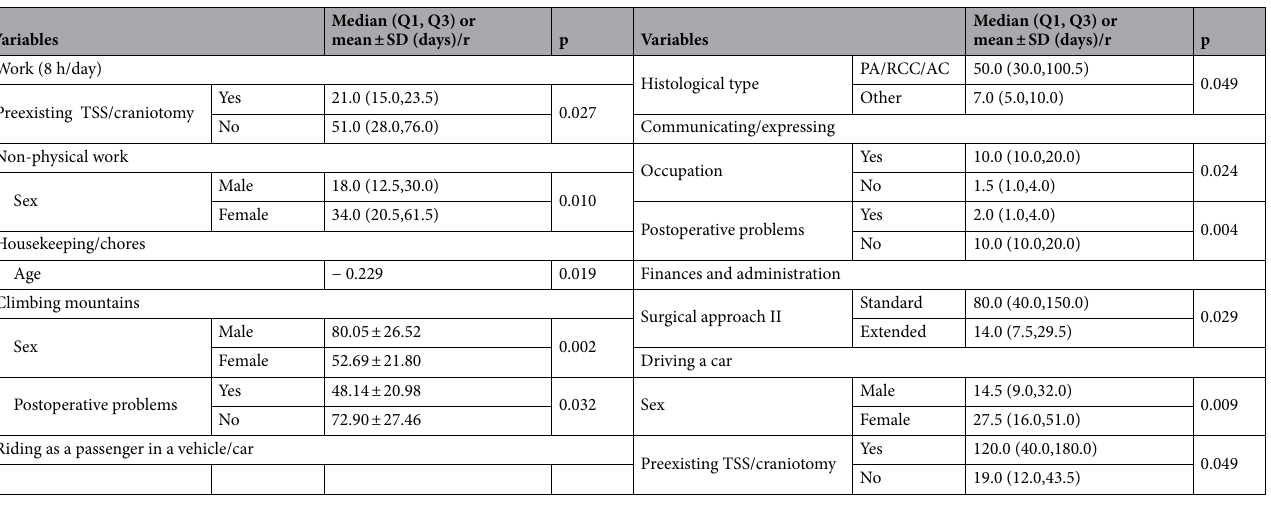
Table 3. Differences in the time to return to ADL according to the clinical characteristics (including significant variables). AC Arachnoid cyst, ADL Activities of daily living, CSF Cerebrospinal fluid, PA Pituitary adenoma, RCC Rathke cleft cyst, TSS Transsphenoidal